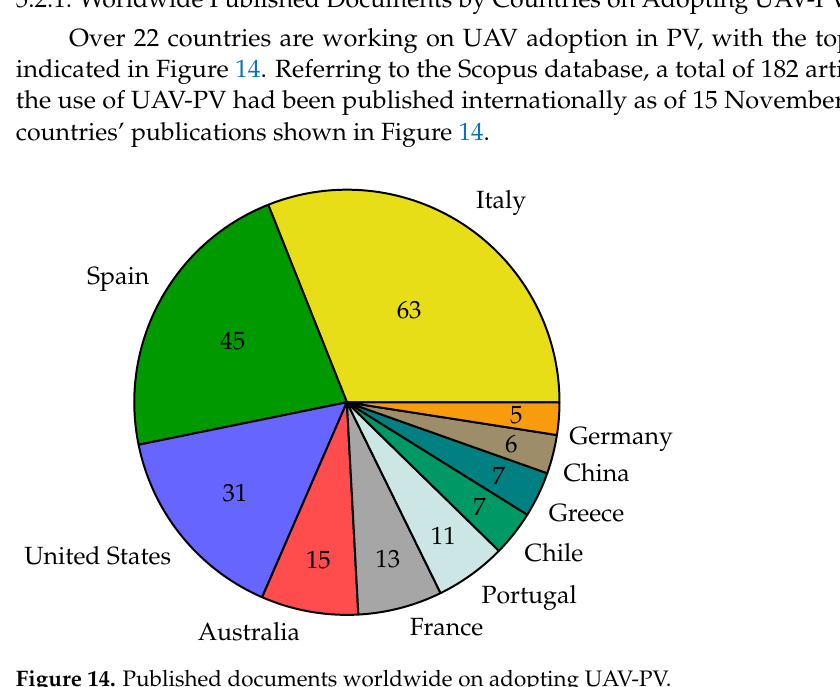
Figure 14. Published documents worldwide on adopting